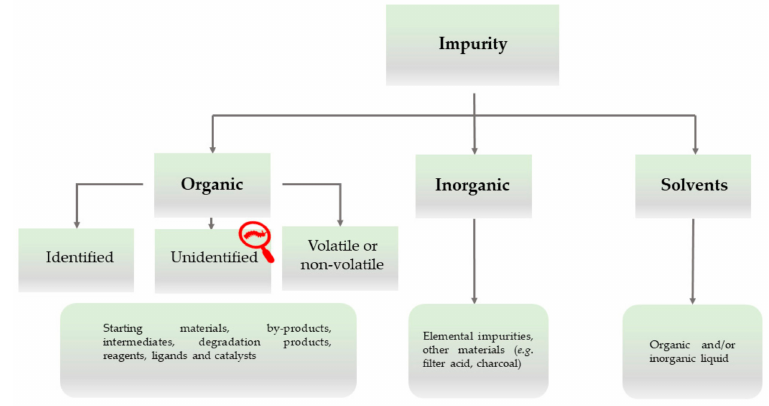
Figure 2. The classification of impurities by the